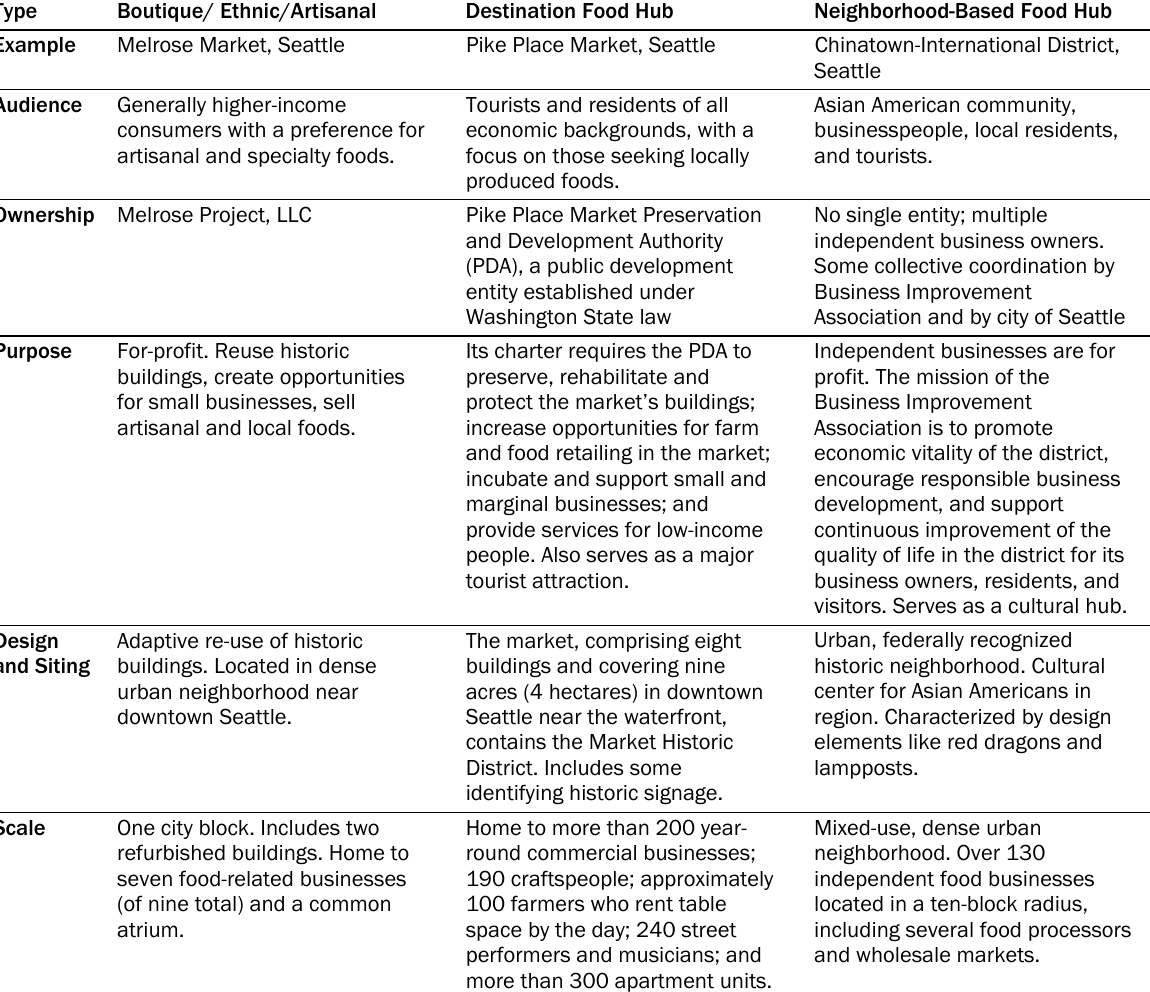
Table 3. Important Food Hub Considerations: Audience, Ownership and Purpose, Design and Siting, and